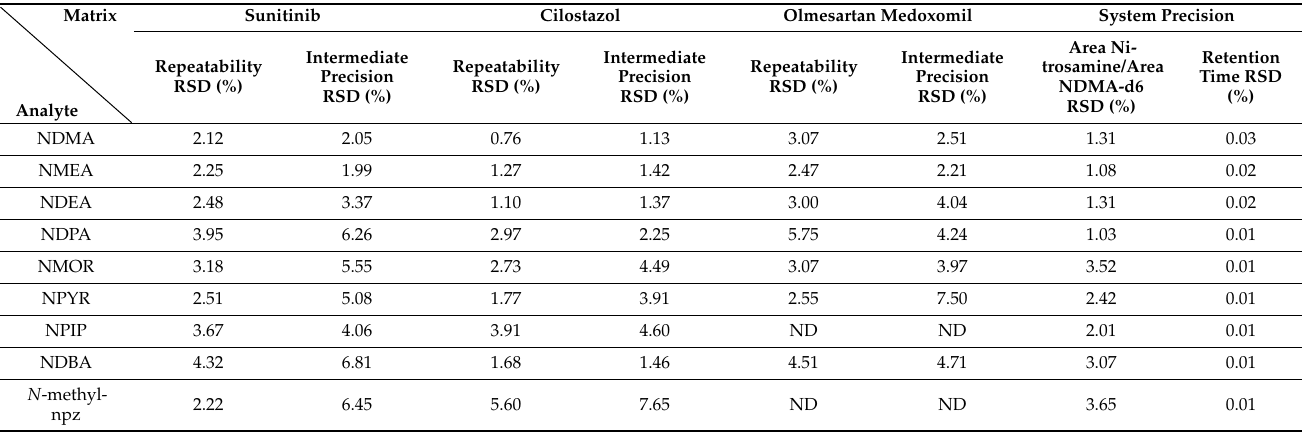
Table 3. Validation results of precision for sunitinib malate, cilostazol, and olmesartan